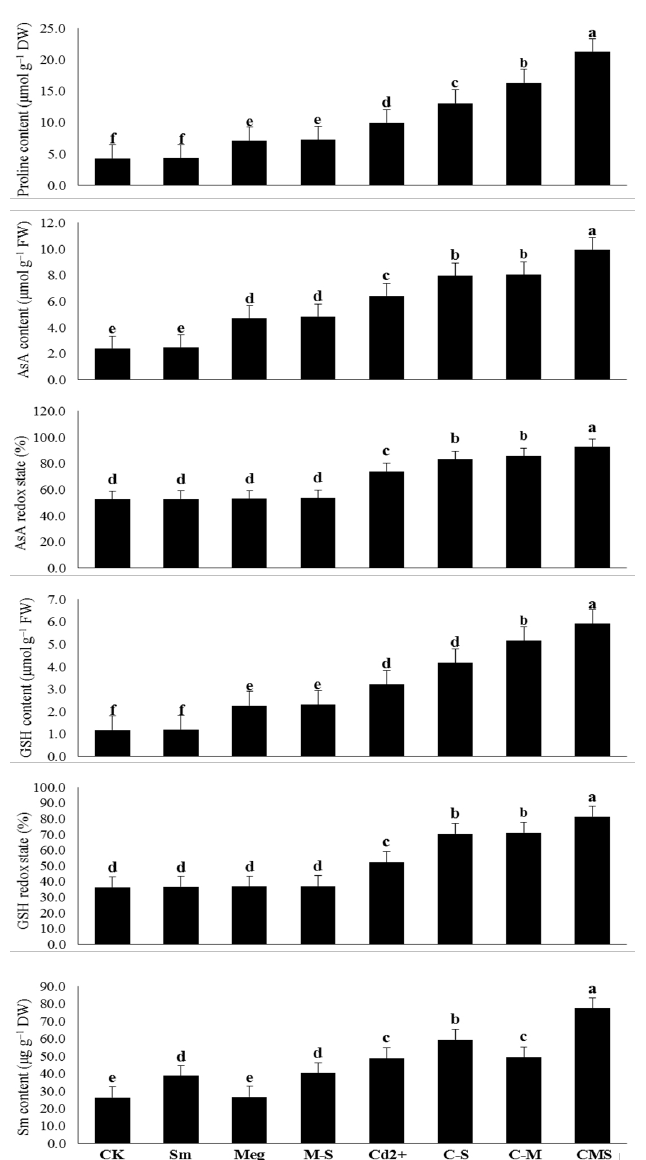
Figure 3. Response of free proline content, level, and redox state of ascorbate (AsA) and glutathione (GSH) of maize plants to foliar application of silymarin (Sm), maize grain extract (MEg), or silymarin-enriched maize grain extract (MEg-Sm) under Cd stress. The same letters on the bars (mean ± SE) of the parameters indicate nonsignificant differences, while the significant differences are a result of different letters according to the least significant difference (LSD) test ( P ≤ 0.05). CK = control, Sm = silymarin, Meg = maize grain extract, M-S = silymarin-enriched maize grain extract, C-S = Cd+Sm, C-M = Cd+Meg, CMS = Cd+Meg+Sm.